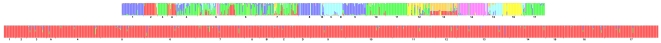
Average assignment probability of individuals of Eriosoma lanigerum (aphid host), independent of sampling origin.Assignment is based on 100 repetitions of 50,000 sweeps using TESS showing K = 7 genetic clusters and the correspondent structure for its parasitoid Aphelinus mali. Individuals (bars) are from North to South.